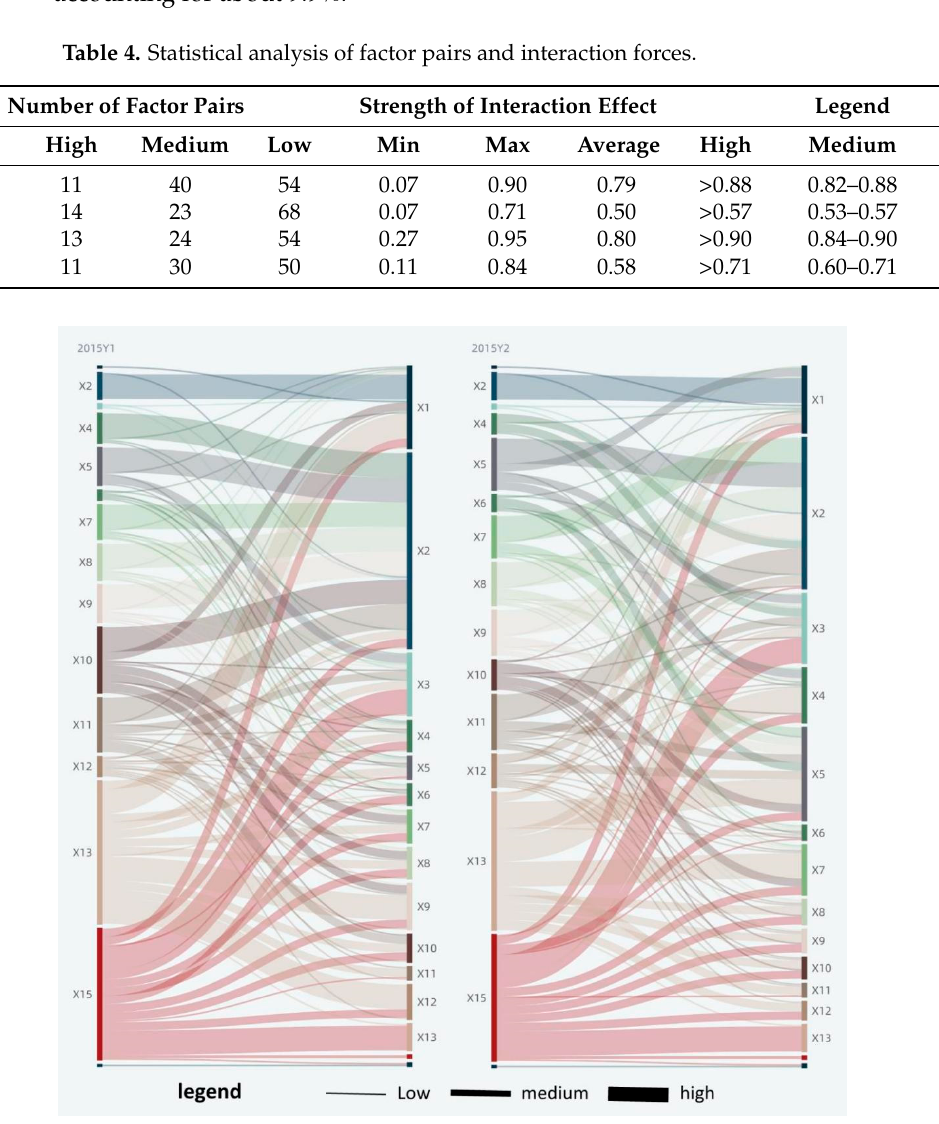
Figure 8. Analysis of interaction detector in 2015. Significantly, in the interaction factor pairs of urban green area ( Y 1 ), the interaction between urban area ( X 5 ) and per capita GDP ( X 2 ), and that between the urban population ( X 4 ) and per capita GDP ( X 2 ) were the highest in 2015, reaching 0.95 and 0.94, respectively. It indicates that at the initial stage of the study, the interaction between urban area,